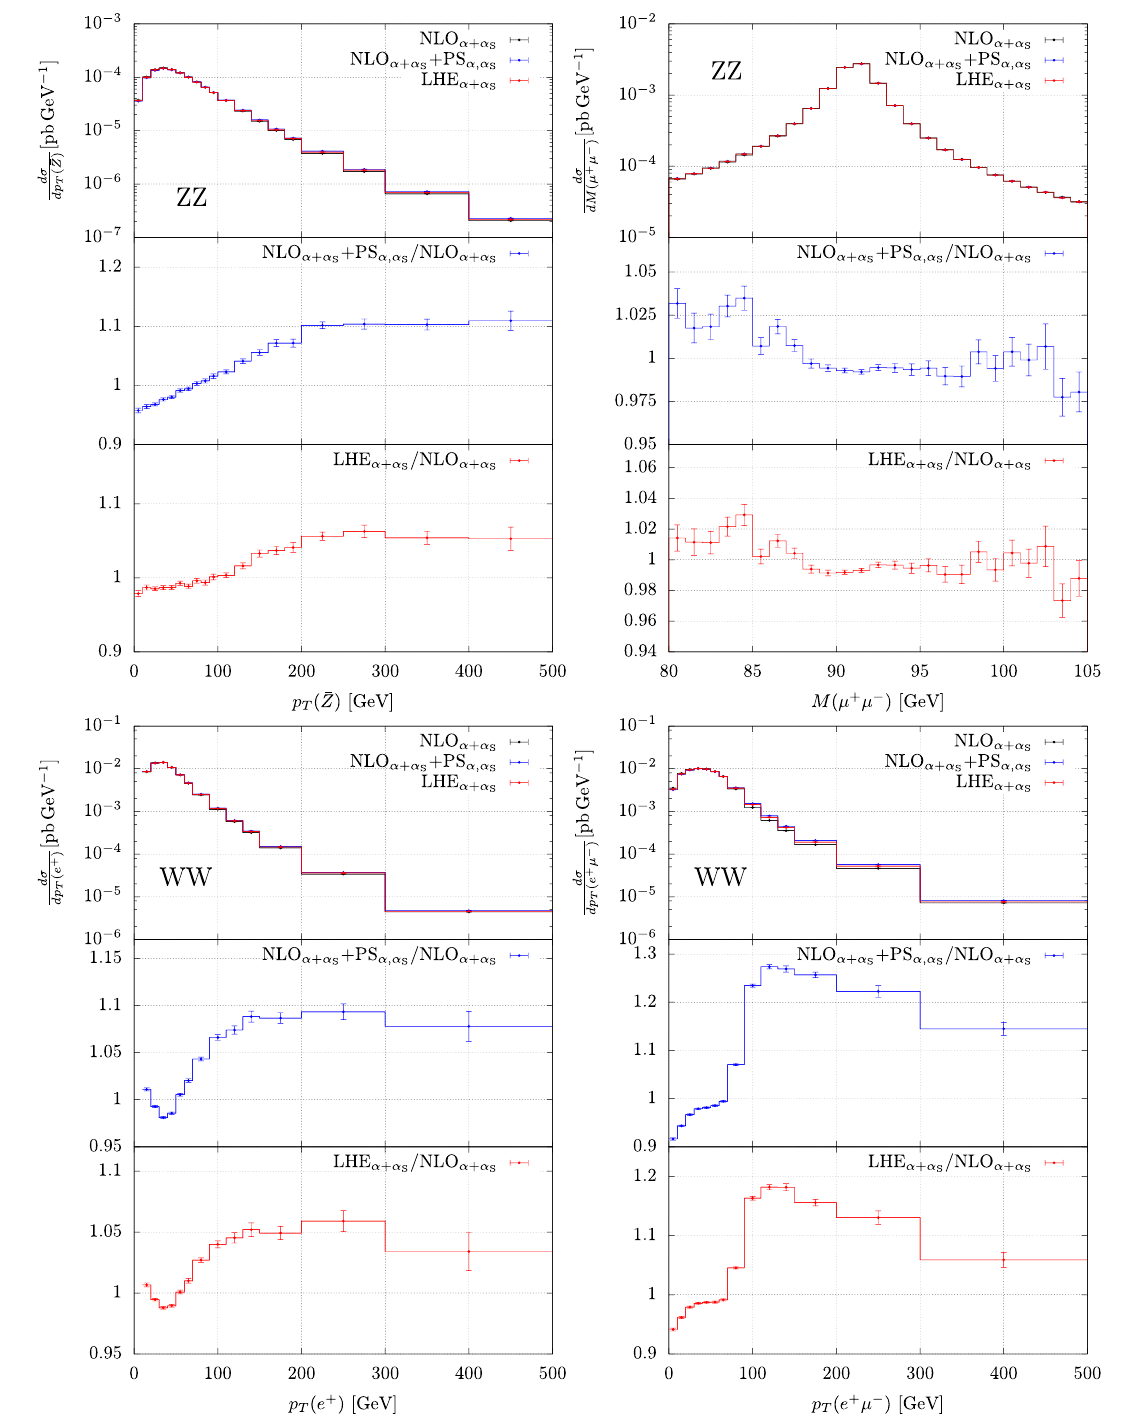
Fig. 6 Comparison of the predictions at NLO QCD + NLO EW + and of the transverse momentum of the positron (bottom left) and of the positron–muon system (bottom right). Central panels: ratio of the PS QCD , QED (NLO α + α + PS α,α ), at LHE (LHE α,α ), and at fixed- S S S predictions at NLO QCD + NLO EW + PS QCD , QED and at fixed-order order NLO QCD + NLO EW (NLO α + α ) accuracy for the processes S pp → μ + μ − e − e + (upper plots) and pp → e + ν e μ − ν μ (lower plots). NLO QCD + NLO EW accuracy. Lower panels: ratio of the results at the Upper panels: differential distributions as a function of the transverse LHE level and at fixed-order NLO QCD + NLO EW accuracy. See main momentum of the same-flavour lepton pair, closer in virtuality to the text for nominal Z mass (top left), of the dimuon invariant mass (top right),